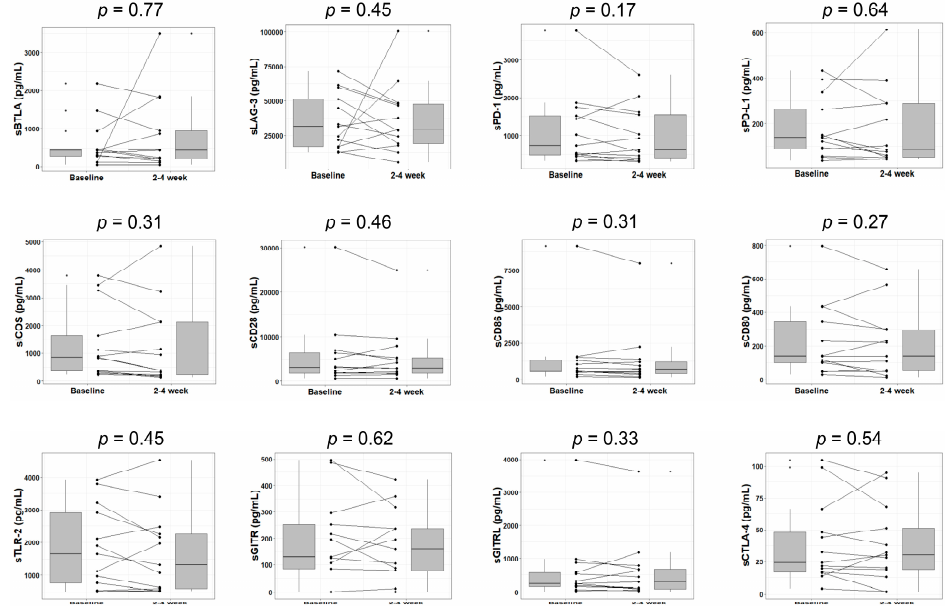
Figure A2. Changes in soluble immune checkpoint protein levels after two to four weeks of lenvatinib treatment. Box plots display the sBTLA, sLAG-3, sPD-1, sPD-L1, sICOS, sCD28, sCD86, sCD80, sTLR-2, sGITR, sGITRL, and sCTLA-4 levels in HCC patients at baseline and Week 2 through 4 of treatment. The vertical lengths of the boxes indicate the interquartile ranges and the lines in the boxes show the median values, while the error bars reveal the minimum and maximum values (range). The Wilcoxon signed-rank test was used.